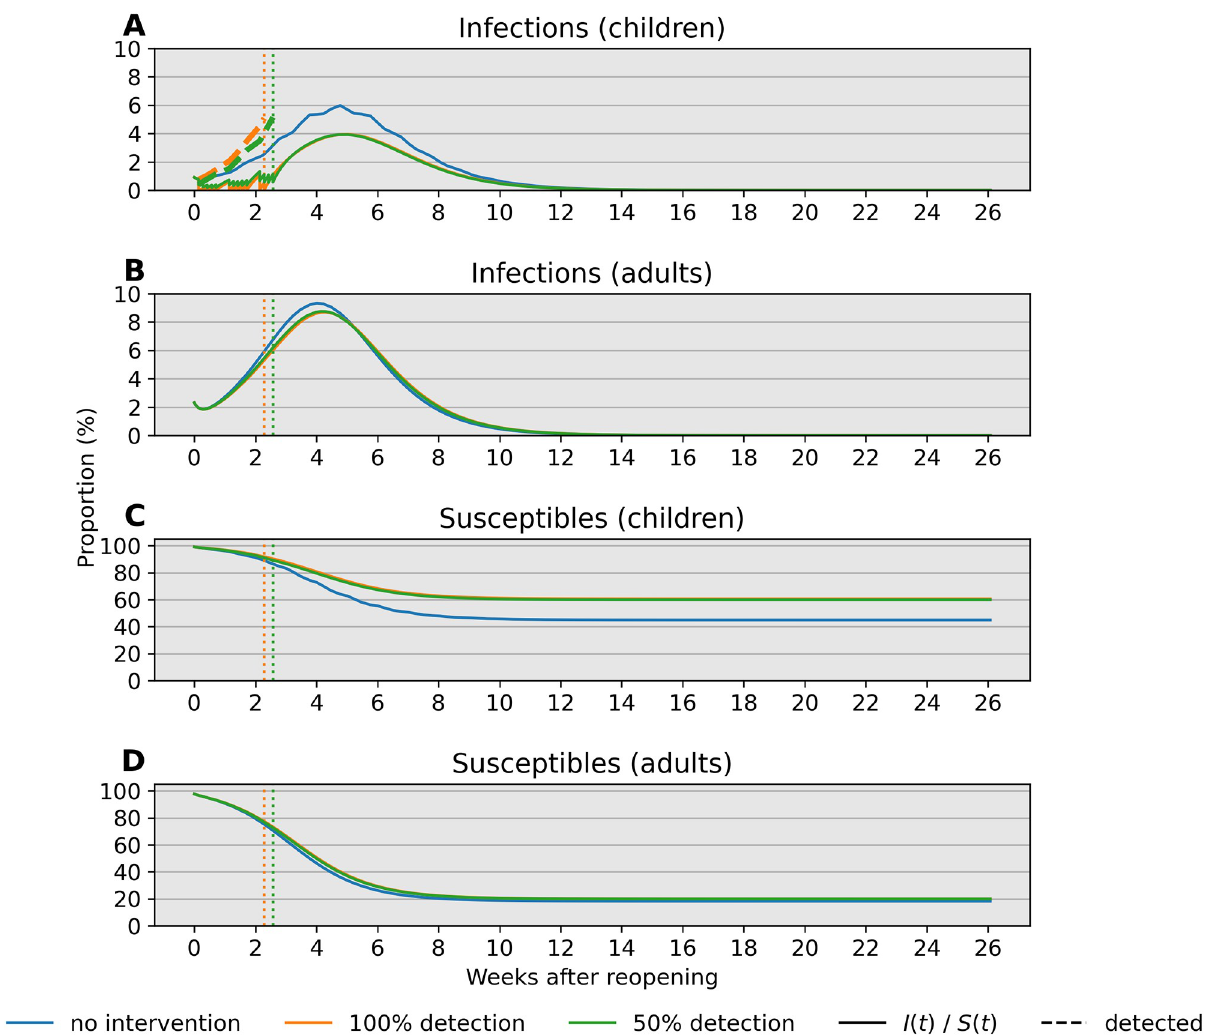
Fig 4. Comparison of infections and susceptibles under different test sensitivities in both children and adults. Simulations are based on parameter values f 11 = 0.1, f 12 = 0.25, f 21 = 0.15, and f 22 = 0.5 with bulk transmission rate β 0 = 1.2. Reopening takes place at a 2% prevalence level (2000 infections per 100,000). The decision criterion over a 14-day sliding window is highlighted in a dotted line. Blue, orange, and green lines correspond to scenarios without intervention, with a 100% sensitive test, and a 50% sensitive test, respectively. (A) The 14-day prevalence criteria hits the 5% threshold after just over 2 weeks in the two testing scenarios. (B) Prevalence in adults peaks after about 4 weeks independent of test sensitivity in children. (C) Testing is effective in keeping most children safe from infection regardless of test sensitivity. (D) Testing in children has little impact on keeping adults free from infection under these